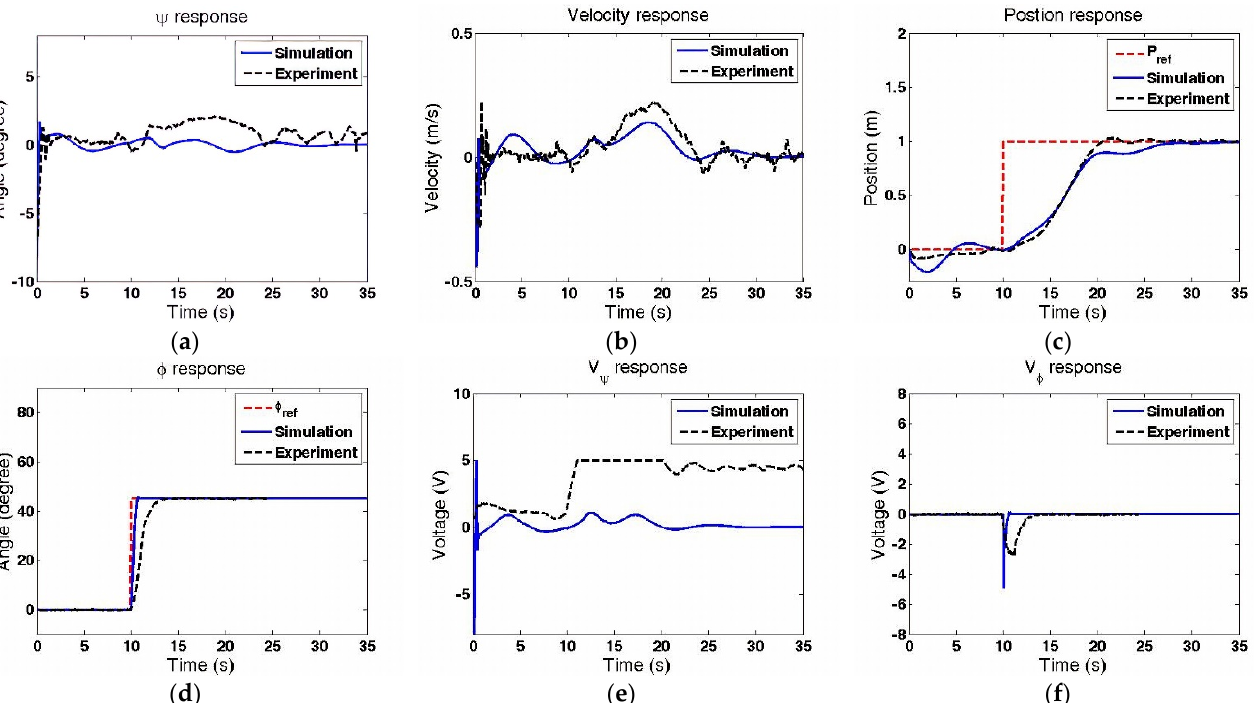
Figure 11. The multi-loop control structure.